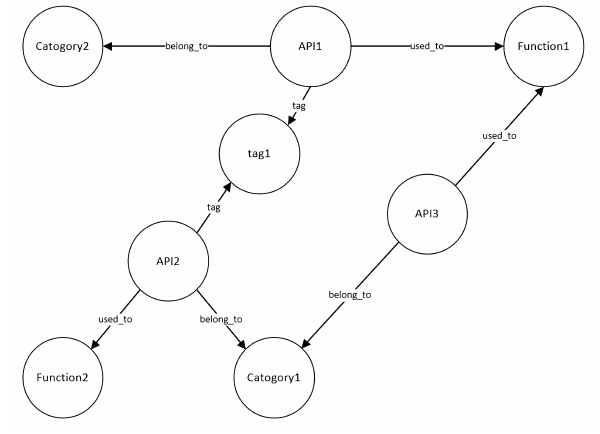
Figure 2. Service knowledge graph entity relationship diagram.